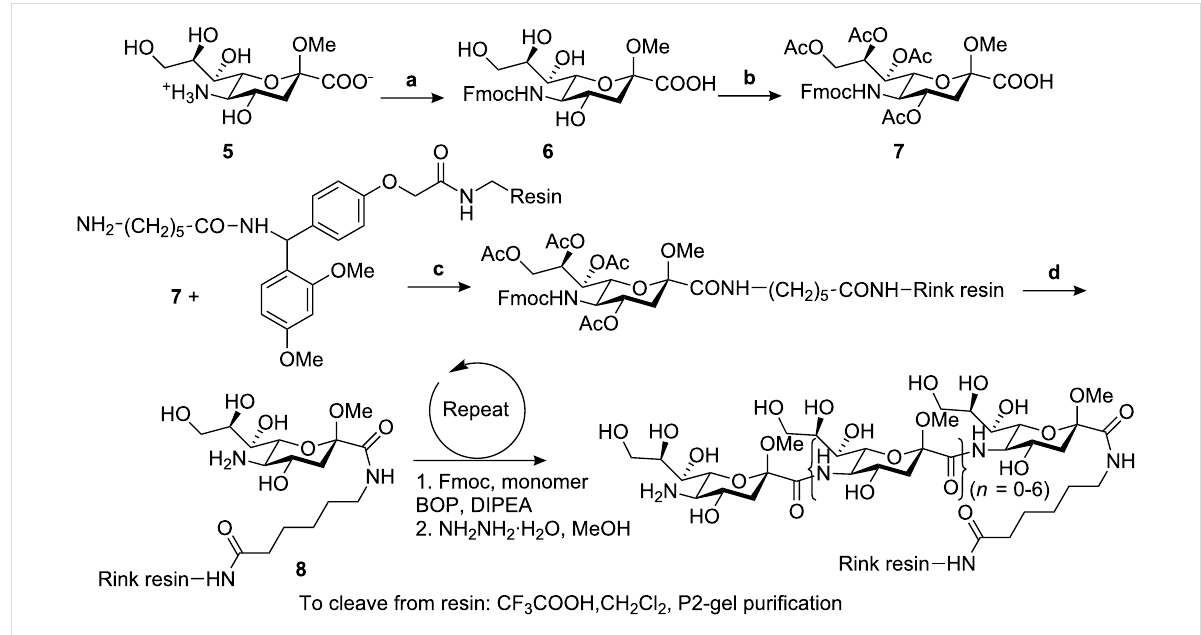
Scheme 1: Synthetic route to the target amide-linked sialooligomers. (a) Fmoc-Cl, NaHCO 3 , H 2 O, dioxane, 0 °C. (b) Ac 2 O, Pyridine, 0 °C. (c) BOP, DIPEA. (d) NH 2 NH 2 ·H 2 O, MeOH.